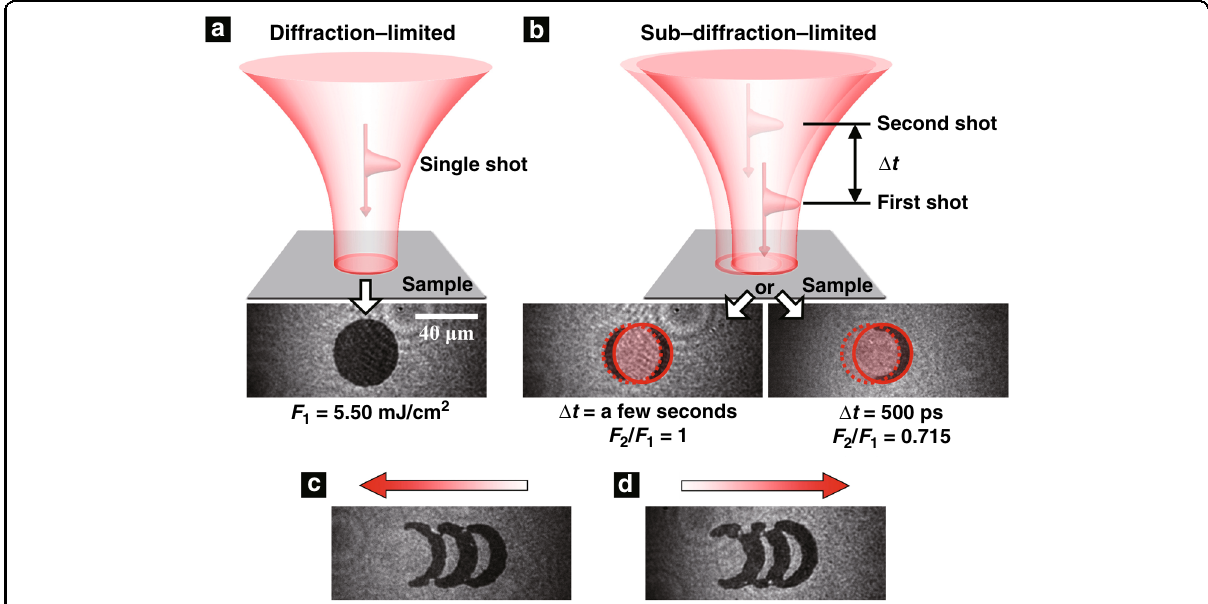
Fig. 4 Proof-of-principle demonstrations of sub-diffraction all-optical switching. a The fi nal magnetization state induced by a single pulse. b The fi nal magnetization states induced by a pair of spatially offset and time-delayed dual pulses with Δ t = a few seconds and Δ t = 500 ps. The solid and dashed circles indicate the irradiation areas of the fi rst and second pulses, respectively. c , d The one-dimensional sub-diffraction all-optical switching array recorded through the dual-shot method ( Δ t = 500 ps) by sweeping the dual pulses from the right side to the left side of the sample ( c ) or vice versa ( d ). The red arrows indicate the sweeping directions. The scale bar is 40 μ